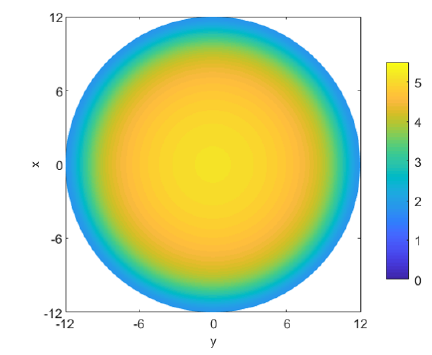
Figure 1. Order parameter as a function of space coordinates when (cid:10) = 0 : 168.